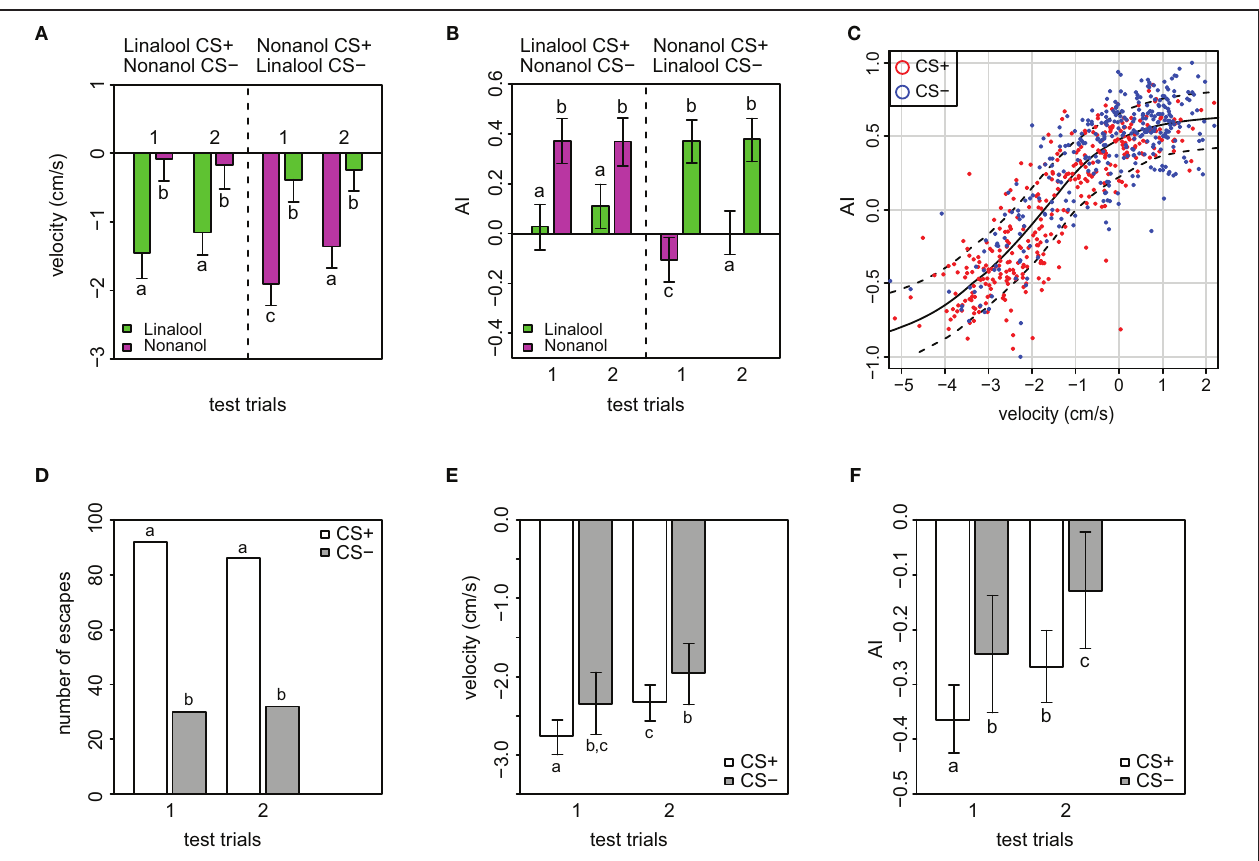
FIGURE 3 | Velocity and magnitude of odor response (AI) in APIS. (A) Velocity toward (positive) or away from (negative) the introduced odor in the conditioning chamber during the two first seconds of the stimuli in the test phase. Note the low generalization for this parameter, and that extinction is only evident in nonanol conditioned bees. Additionally, velocity away from the odor is higher for nonanol than for linalool. Error bars indicate 95% credible intervals. Groups that are significantly different ( p < 0 . 05, by proportion of simulated parameters from one group occurring within the credible interval of the compared group) are indicated by different letters above the bars ( N = 83 and 91 bees that received either linalool or nonanol as CS + , respectively). See Figure A3 for goodness of fit. (B) Magnitude of odor responses represented by the mean Attractance Index (AI) for the different stimuli of the test phase in APIS. Note the low generalization, and that AI reveals extinction only in the nonanol conditioned bees. Error bars indicate 95% credible intervals. Groups that are significantly different ( p < 0 . 05) are indicated by different letters above the bars ( N = 83 and N = 91 bees that received either linalool or nonanol as CS + , respectively). See Figure A4 for goodness of fit. (C) AI plotted against velocity, red: CS + , blue: CS − . Loess smoothing (solid line) and